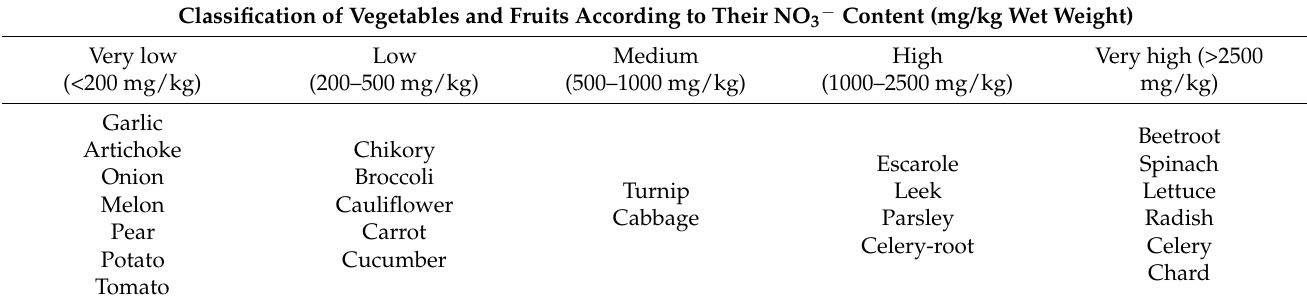
Table 1. Classification of different vegetables and fruits according to their nitrate content. Adapted from Moreno et al., 2015 [14]. Classification of Vegetables and Fruits According to Their NO 3 − Content (mg/kg Wet